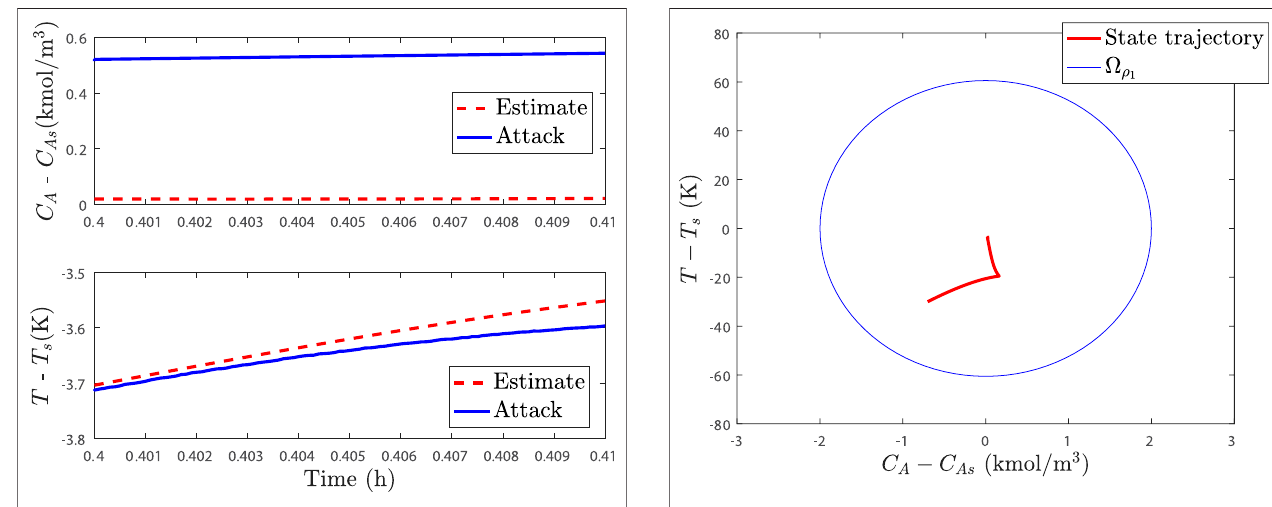
FIGURE 5 | Stability region and closed-loop state trajectory for the process example in the presence of multiple cyberattack policies (baseline